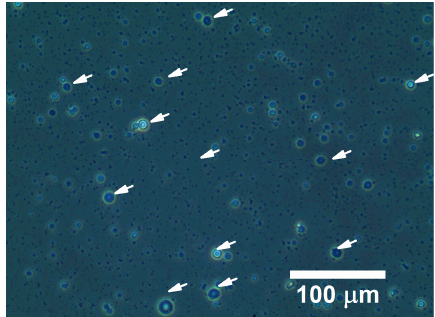
Figure 3. Image of hemoglobin (Hb)-loaded microcapsules (indicated by white arrows) prepared under the optimized condition.